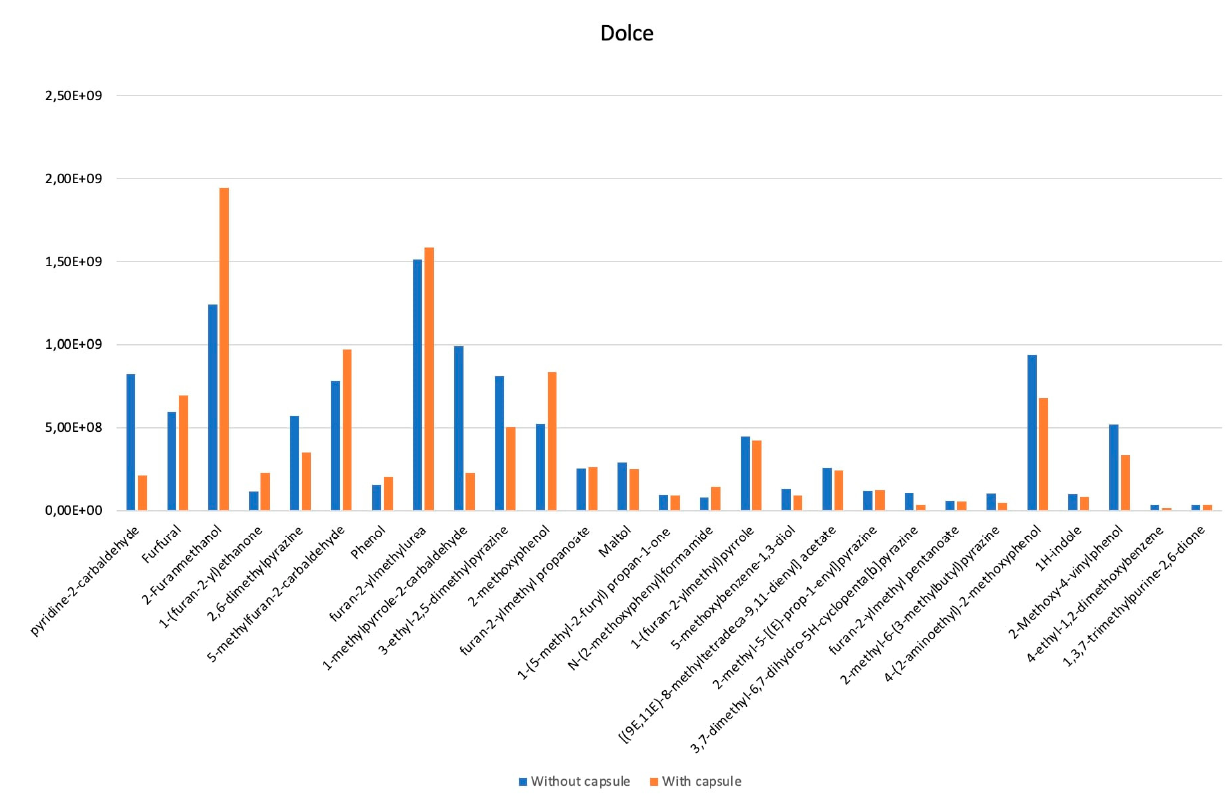
Figure 3. Comparison abundance value of common compound between Dolce coffee “with capsule” and “without capsule”.